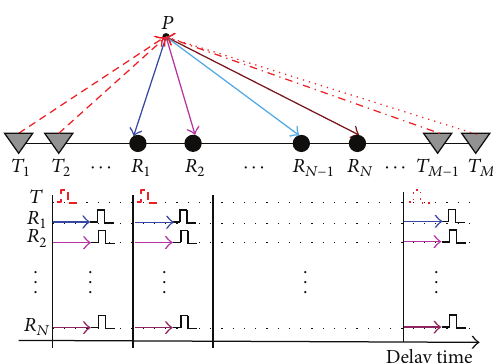
Figure 2: Transmitting and receiving order of down-looking sparse array